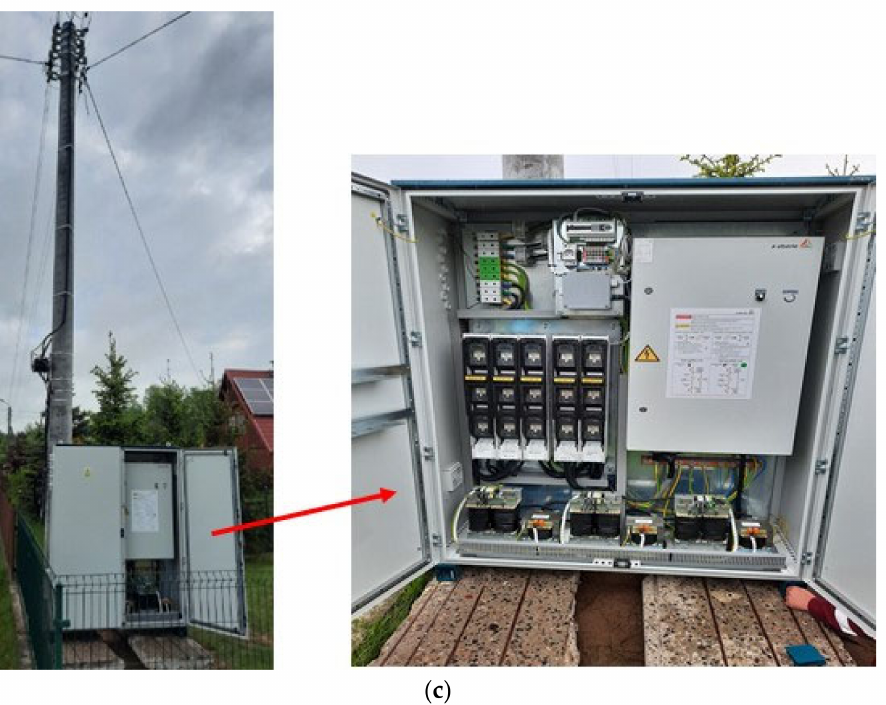
Figure 1. The structure of the LVR-sys regulator ( a ), example of voltage regulation by +3%, according to [26] ( b ), and a view of the tested LVR-sys ( c ).